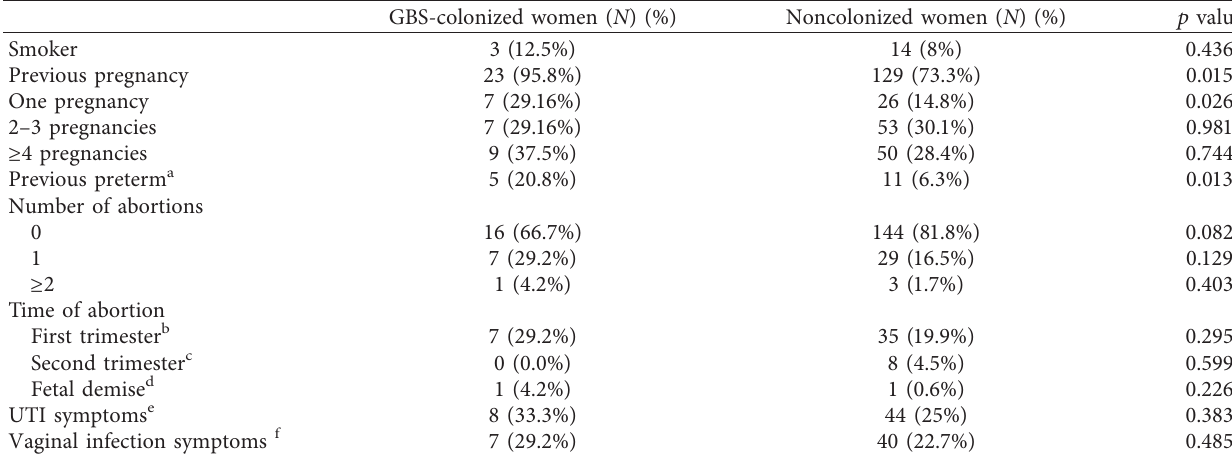
Table 3: The medical history of both GBS-colonized and noncolonized pregnant women.